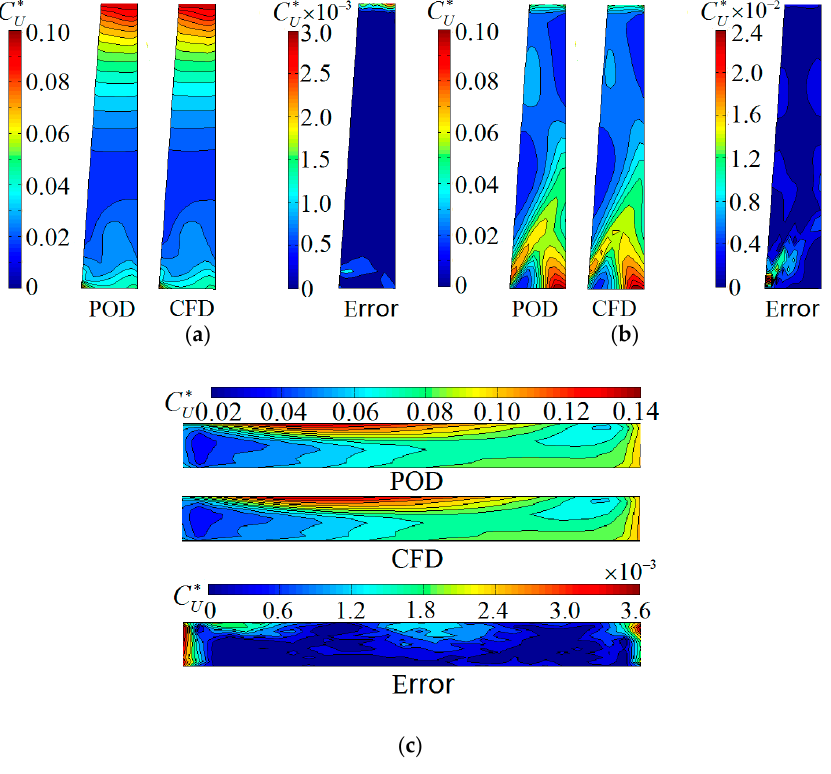
Figure 13. CFD calculation, POD reconstruction, and their error of relative velocity fluctuation intensity on the blade surface and circumferential surface of impeller outlet. ( a ) Pressure surface; ( b ) Suction surface; ( c ) Circumferential surface of impeller outlet.